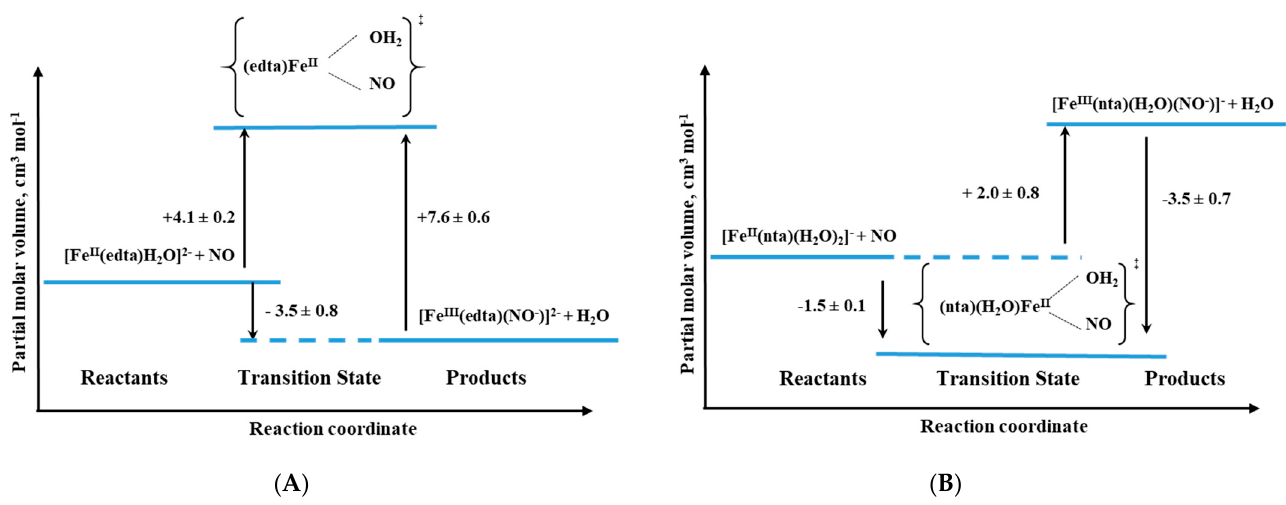
Figure 17. Volume profiles for the reactions of ( A ) seven-coordinate [Fe II (edta)(H 2 O)] 2+ and ( B ) six-coordinate [Fe II (nta)(H 2 O) 2 ] 2+ complexes with NO [37] .